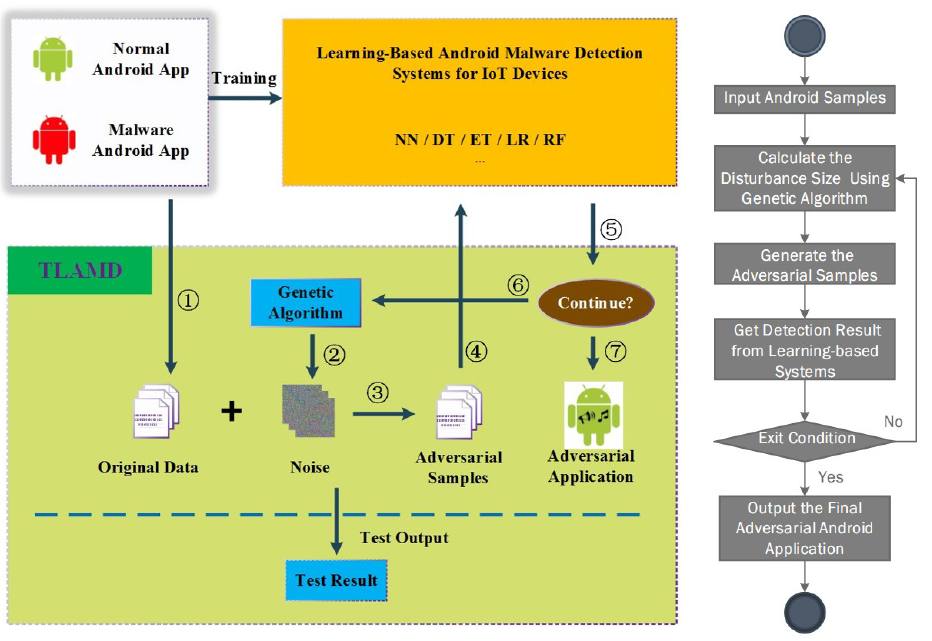
Figure 1. Overview of our testing framework for learning-based Android Malware detection systems for IoT devices. (1) Original Sample Input; (2) Calculate the disturbance size; (3) Generate